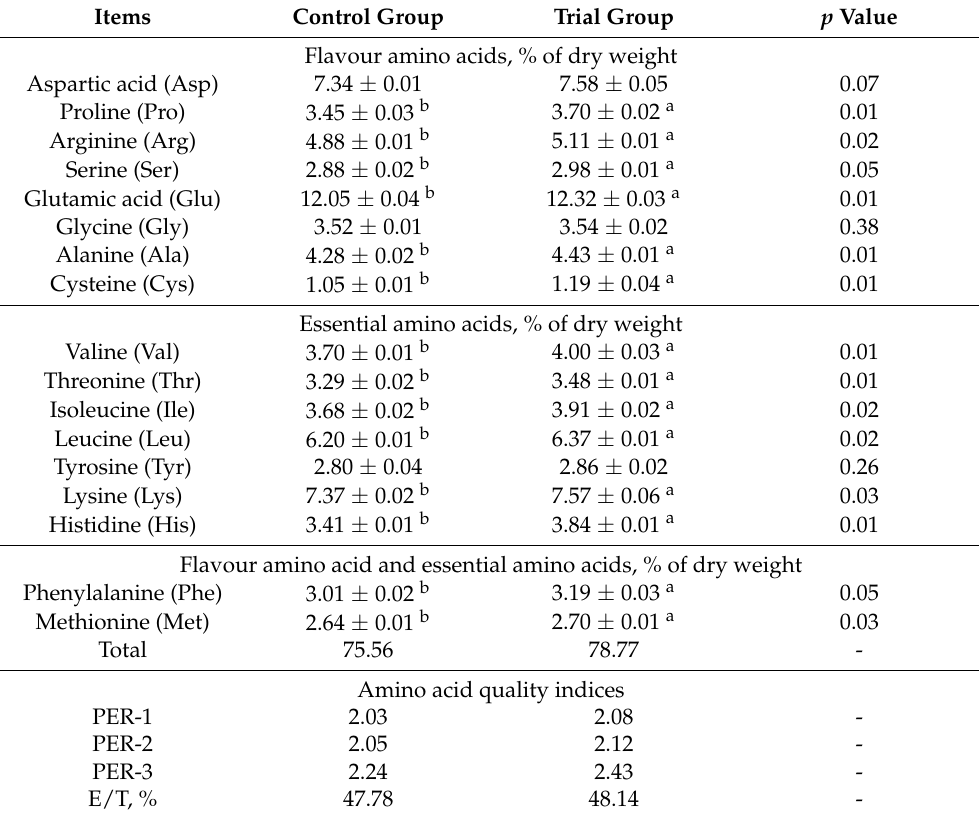
Table 6. Amino acid profile of M. longissimus thoracis et lumborum according to pork group. Items Control Group Trial Group p Value Flavour amino acids, % of dry weight Aspartic acid